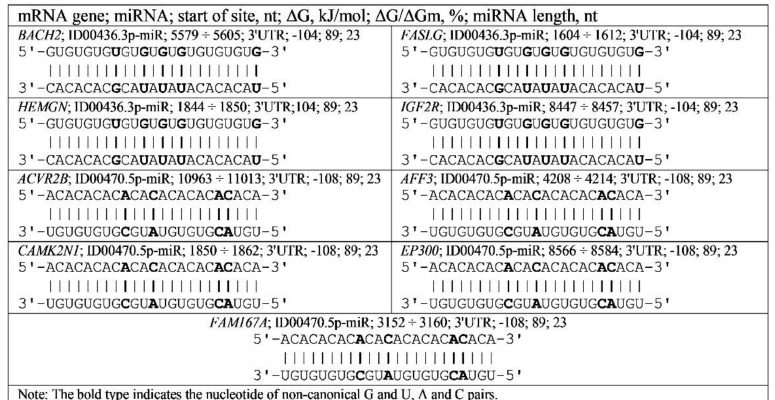
Figure 4. Schemes of ID00436.3p-miR and ID00470.5p-miR binding in mRNA genes having GU and AC nucleotide repeats in 3 (cid:48) UTR.